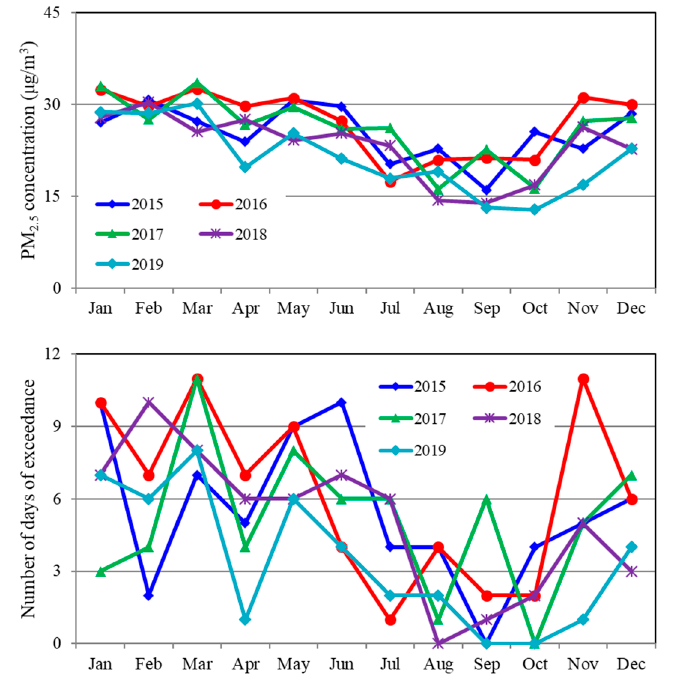
Figure 5. Monthly mean PM 2.5 concentrations ( top ) and the number of days exceeding 35 µ g/m 3 of PM 2.5 ( bottom ) obtained from the Korea air monitoring network in Busan.